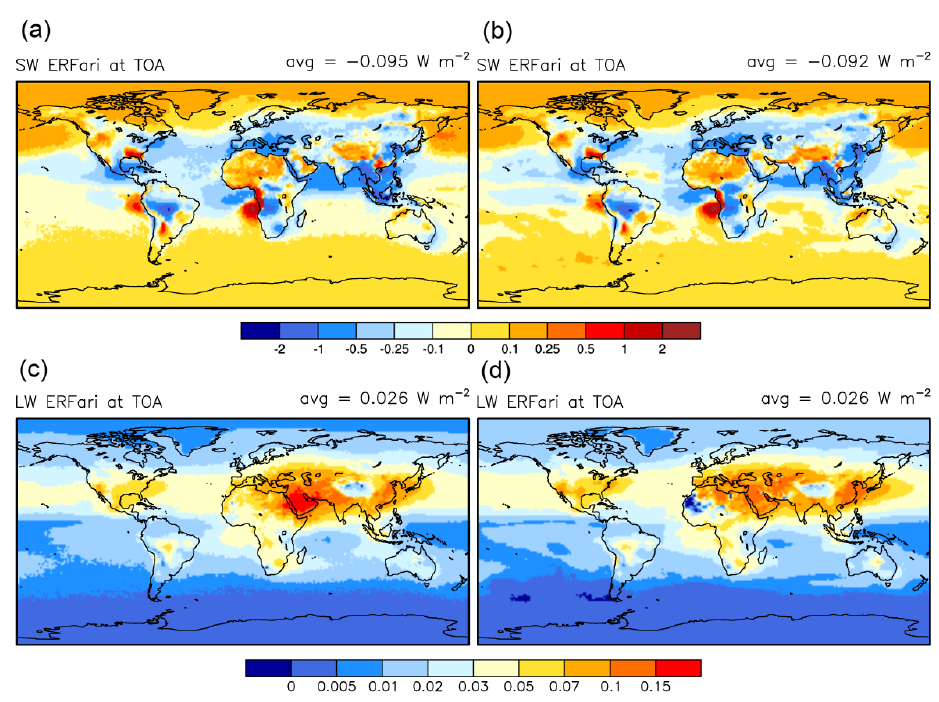
Figure 9. Shortwave (SW, a and b ) and longwave (LW, c and d ) ERFari at the top of the atmosphere (TOA) for the simulations NUDGE_PD– NUDGE_PI ( a and c ) and AMIP_PD–AMIP_PI ( b and d ). Note the different color scales. Note also that the semi-direct effect is not included here, since ERFari in this study corresponds to the “direct radiative forcing” component in Ghan